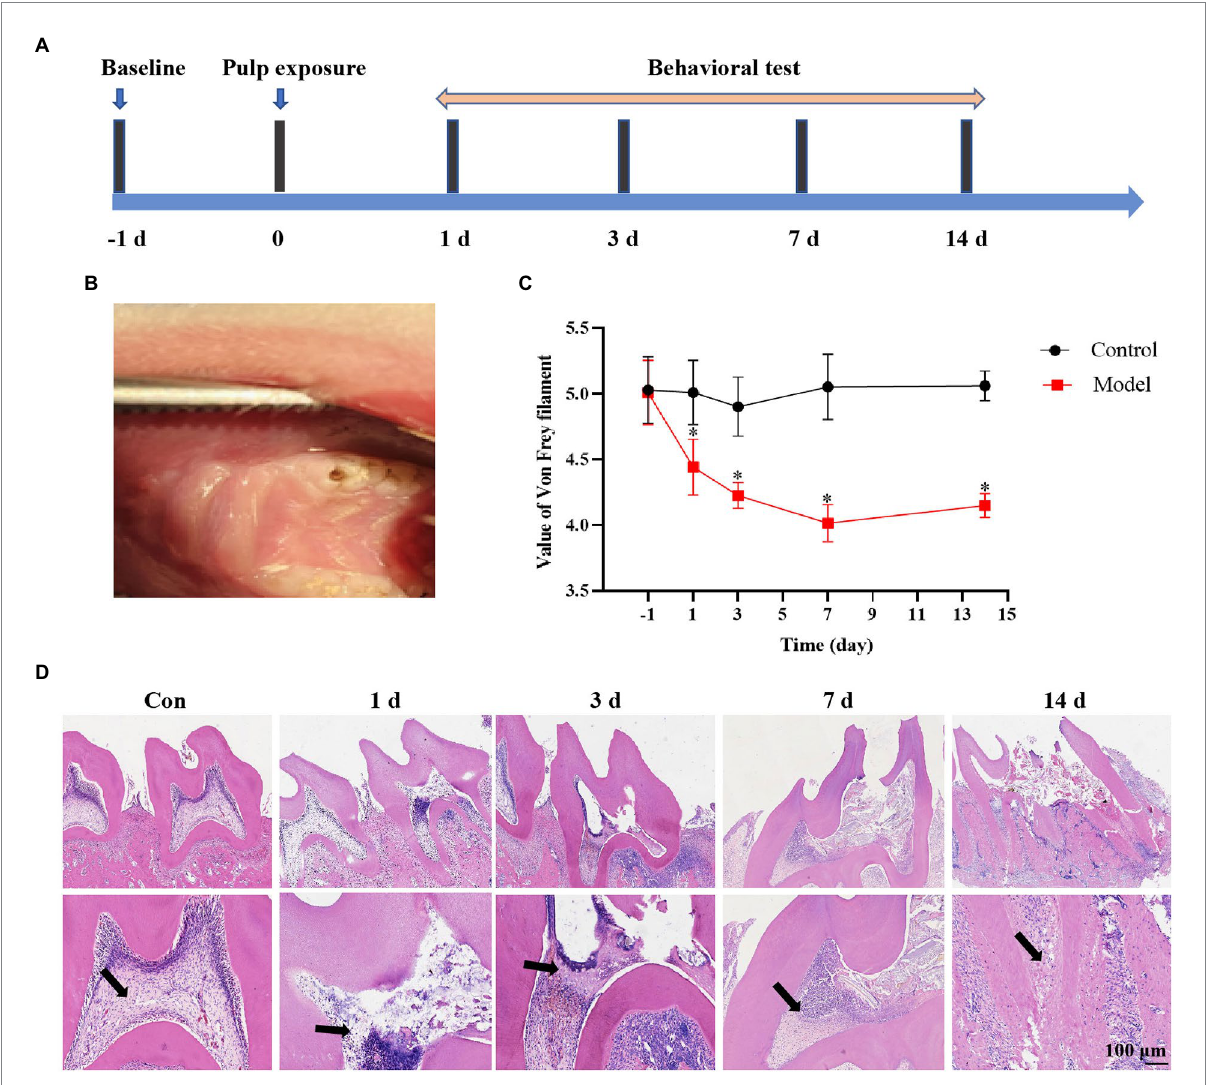
FIGURE 1 Establishment of the rat dental pulpitis pain model. (A) Schedule of pulp exposure treatment and behavioral test. (B) A rat dental pulpitis model was established via dental pulp exposure. (C) The pain threshold decreased with a prolonged exposure time of the dental pulp, reaching the minimum on the seventh day, and then increasing slightly during the next 7 days. * p < 0.05 vs. control. (D) Haematoxylin and eosin (H&E) staining showed that the inflammatory infiltration range in dental pulpitis tissue gradually expanded from the crown to the root pulp as the exposure time prolonged. Scale bar = 100 μ